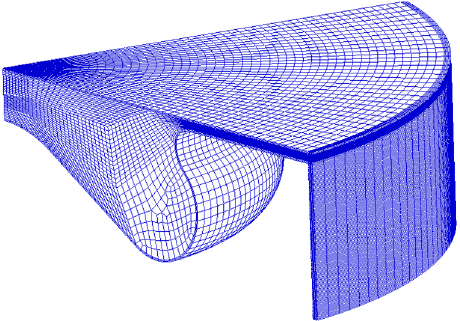
Figure 2. Geometry of combustion chamber at top dead center (TDC).